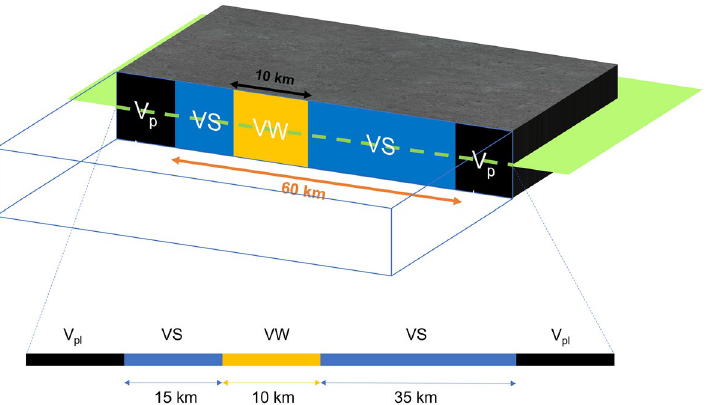
Figure 5. Schematic illustration of fault setup. Top: Our fault is a line fault (dashed green line) with a 60 km long VS region and a 10 km long VW region embedded in it which is offset from the center of the fault by 10 km to the left. The fault is surrounded by a bulk homogenous elastic medium. Bottom: The line fault is obtained by taking a slice of the entire medium shown by the green plane. At the edges, the fault is slipping at the background tectonic loading rate.